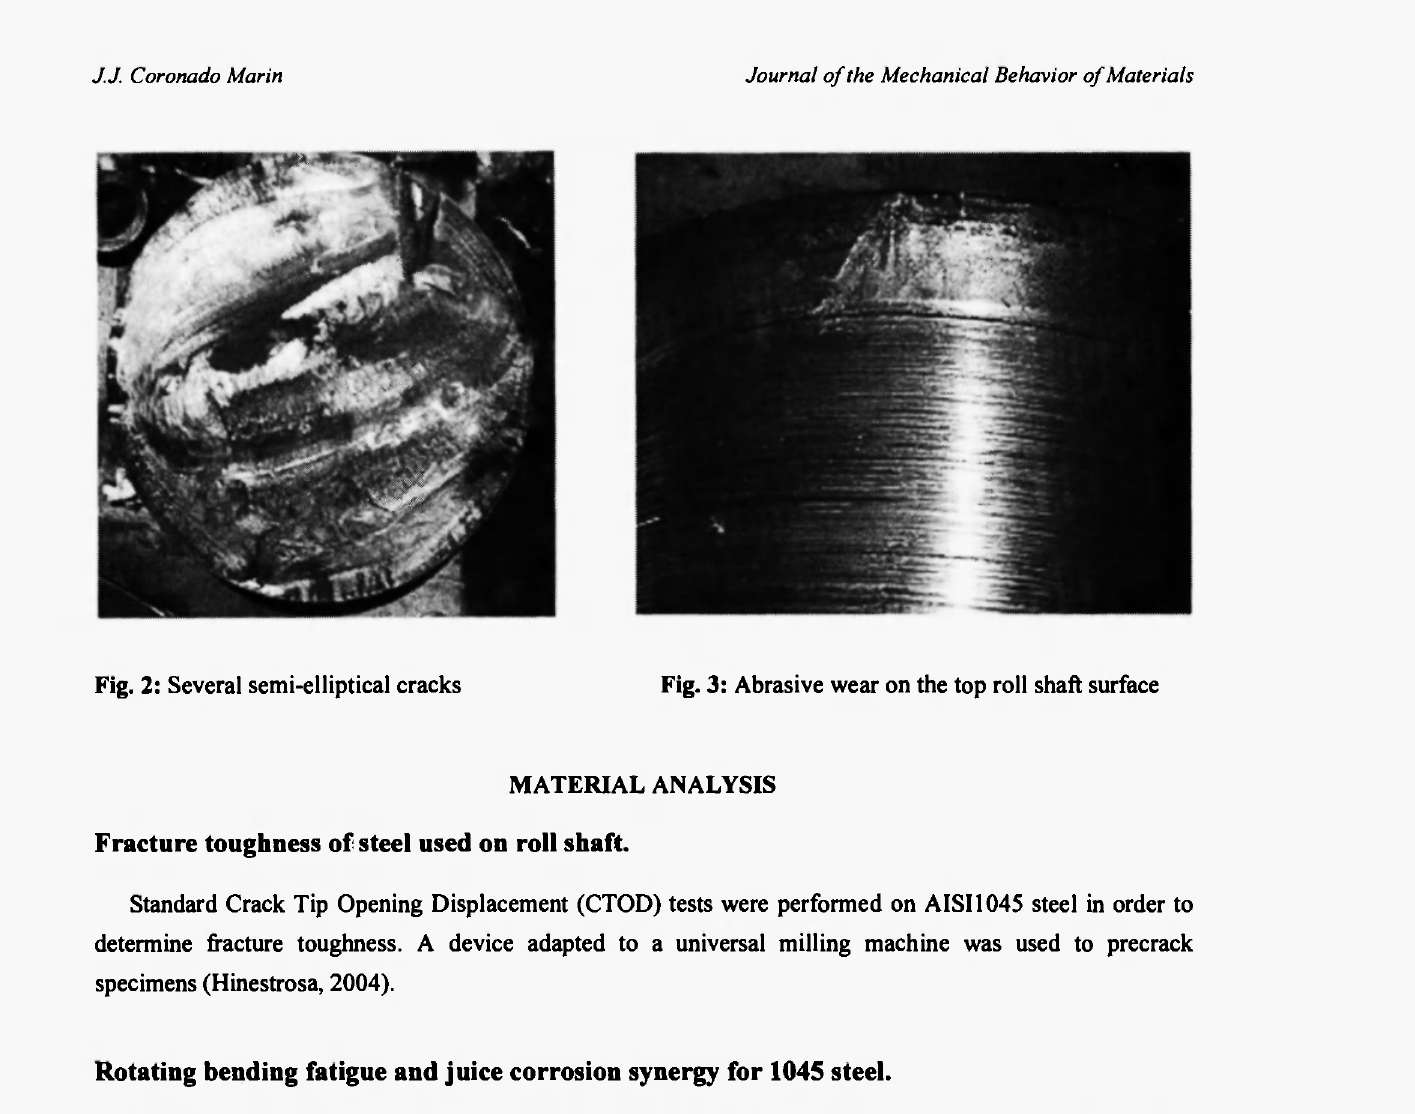
Fig. 2: Several semi-elliptical cracks Fig. 3: Abrasive wear on the top roll shaft